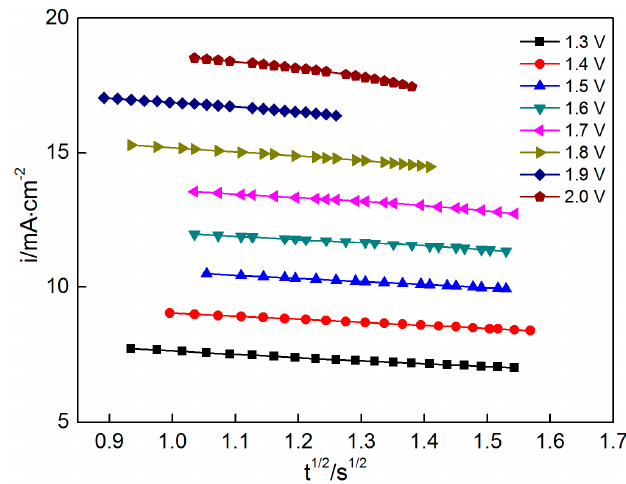
Figure 6. Current i as a function of t 1/2 at various potentials ranging from 1.3 V to 2.0 V.